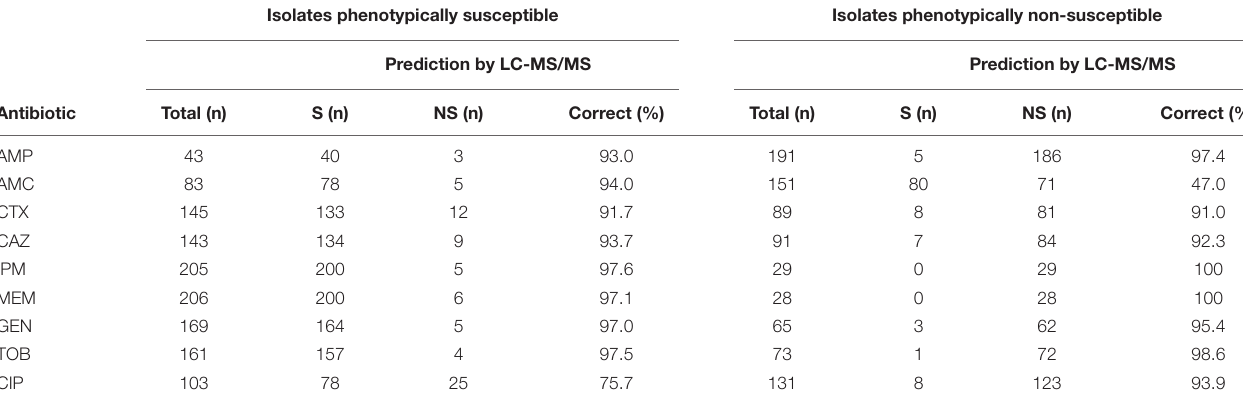
TABLE 4 | Susceptible/non-susceptible predictions for 234 E. coli , K. pneumoniae , and K. variicola isolates based on the detected peptides by LC-MS/MS. Isolates phenotypically susceptible Isolates phenotypically non-susceptible Prediction by LC-MS/MS Prediction by